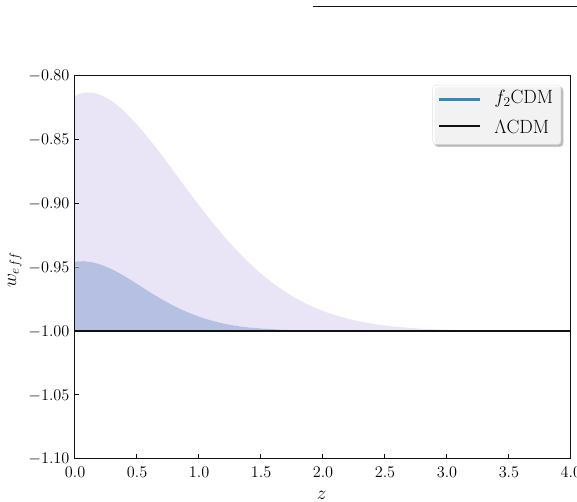
Fig. 5 Evolution of the EoS for (cid:3) CDM and the effective EoS for the f 2 CDM model from the joint analysis